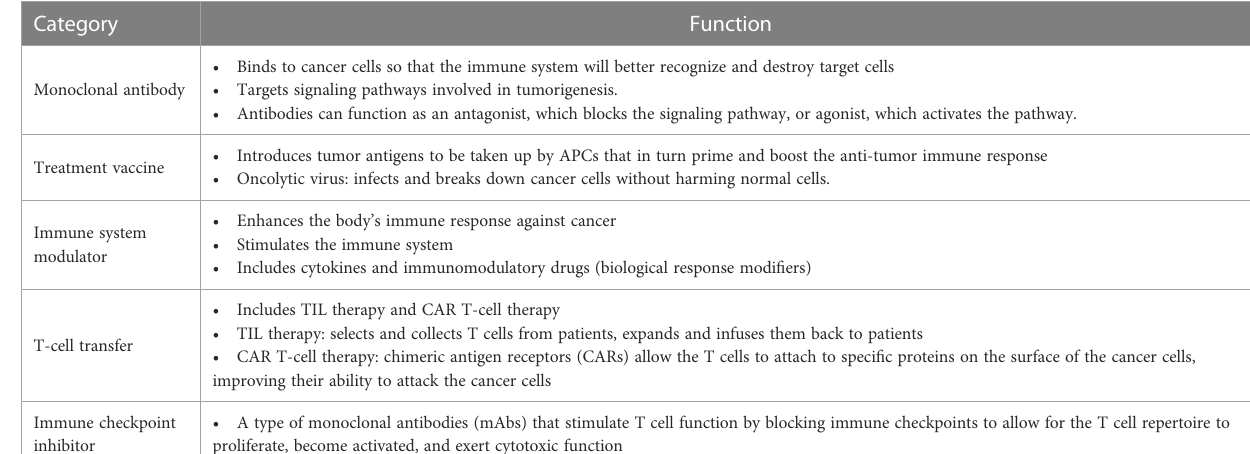
TABLE 5 Categories of cancer immunotherapy and their functions. Category Function